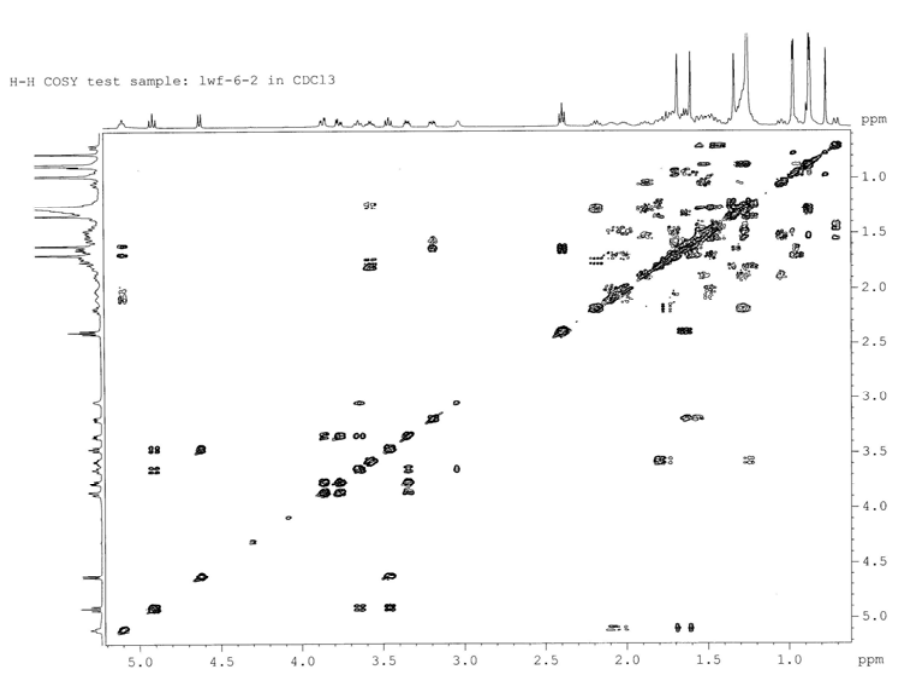
Figure 3. 1 H- 1 H COSY spectrum of 2A